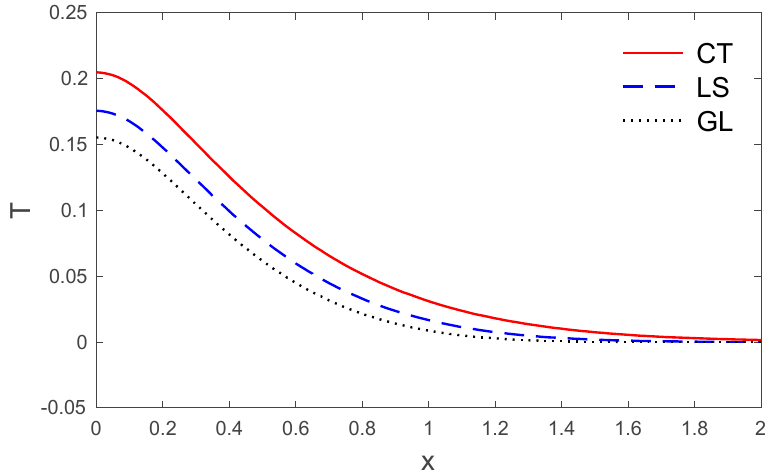
Figure 7. The temperature variation 𝑇 via 𝑥 , with y = 0.5 under the three models.